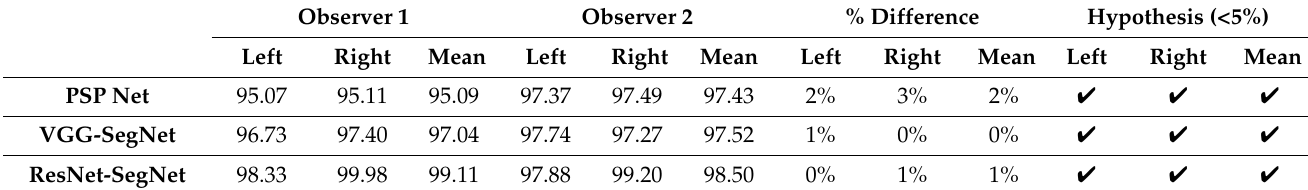
Table 4. FoM for lung